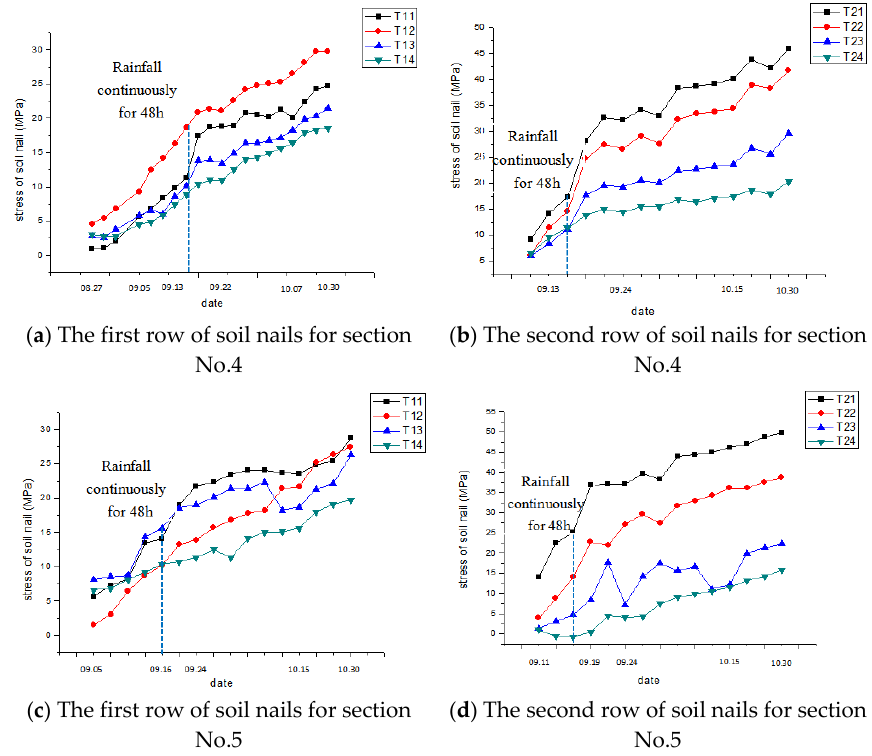
Figure 13. Stresses of the upper two rows for sections No.4 and No.5.